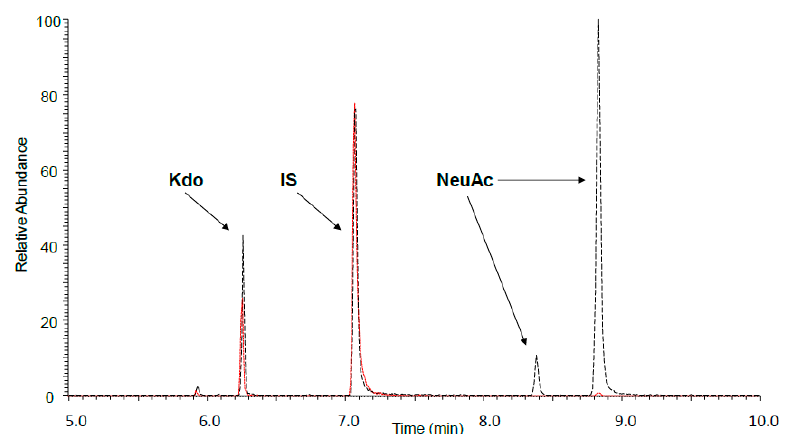
Figure 3. S. Erlangen results of analysis of two single colonies as an example showing high and low NeuAc (sialic acid)/Kdo (3-Deoxy- D -manno-octulosonic acid) ratio: colony 3 (black, dashed line) and colony 4 (red, dotted line) differing in NeuAc/Kdo ratio, superimposed for better view. MS/MS simultaneous analysis of Kdo (marker ion of m / z = 195), NeuAc (ion of m / z = 386), and perseitol (ion of m / z = 128) as an internal standard (IS).